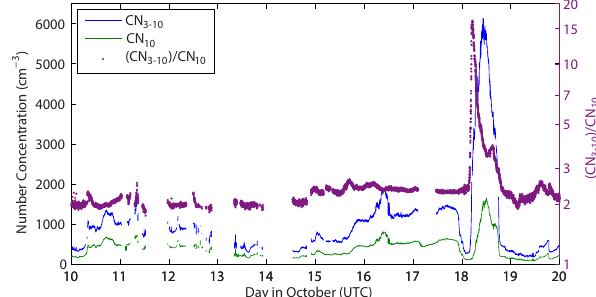
Figure 2. Time series of aerosol parameters for a 10-day subset of the 2012 SIPEXII voyage. Aerosol parameters include calibrated number concentrations of CN 3 − 10 (blue), CN 10 (green) and the ratio CN 3 − 10 / CN 10 (red). The ratio has been shown previously (Warren and Seinfeld, 1985) to be a good indicator of new particle production when limited measurements are